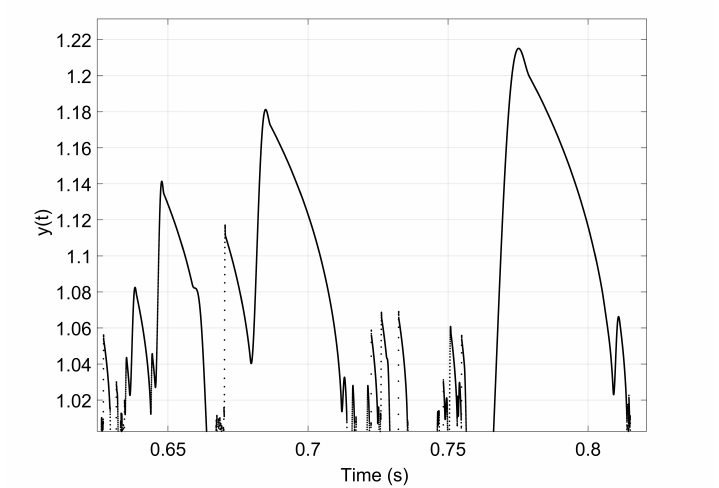
Figure 9. Zoom of the Figure 5 with Matlab